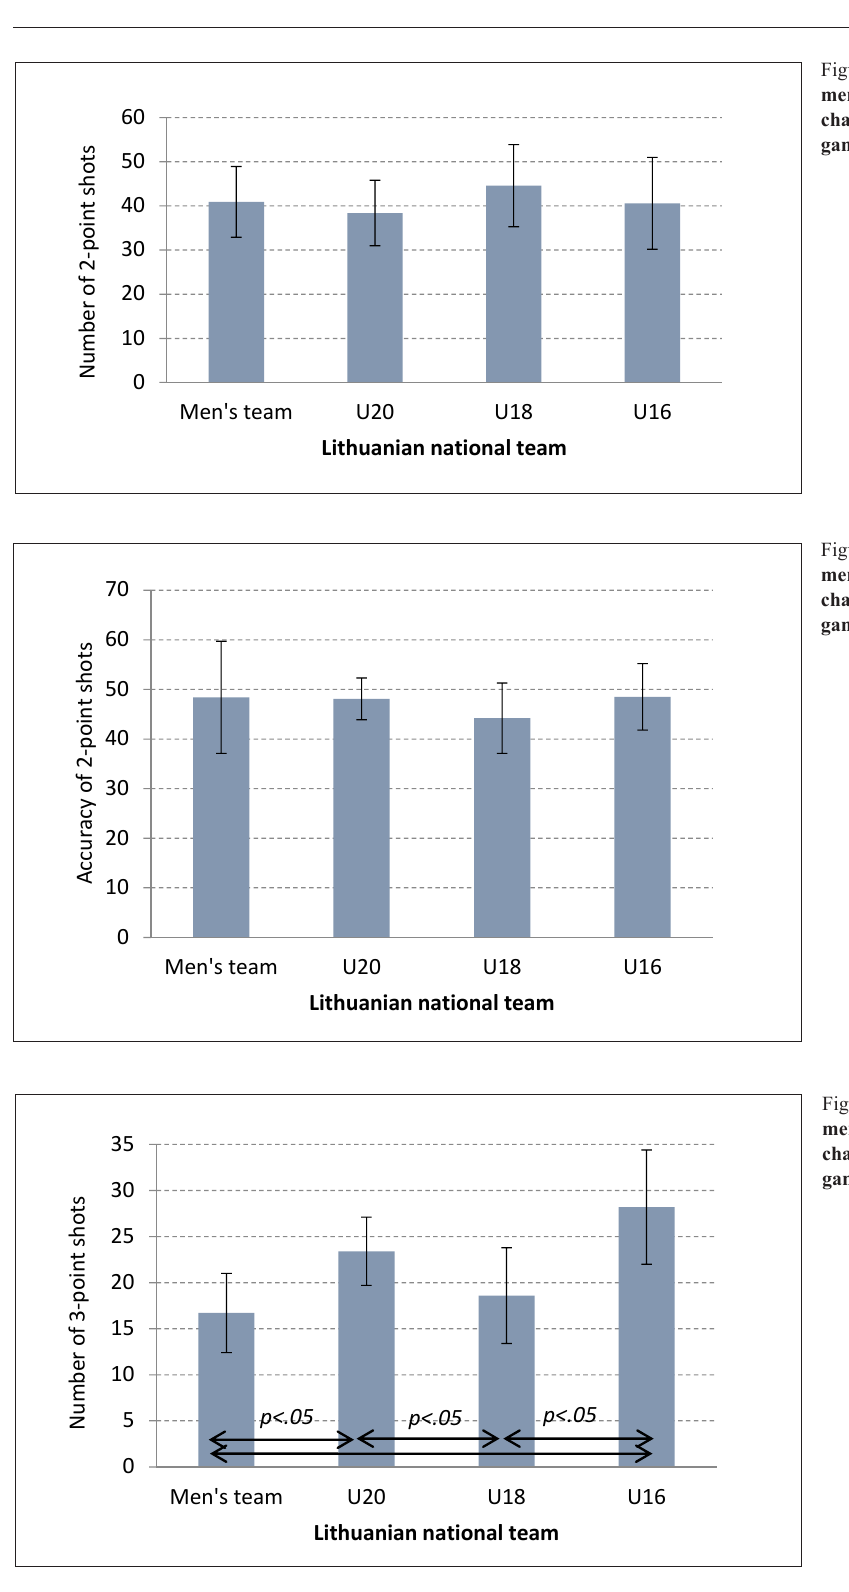
Figure 3. The number of 3-point shots for men’s basketball teams in the European championship matches (average per one game)